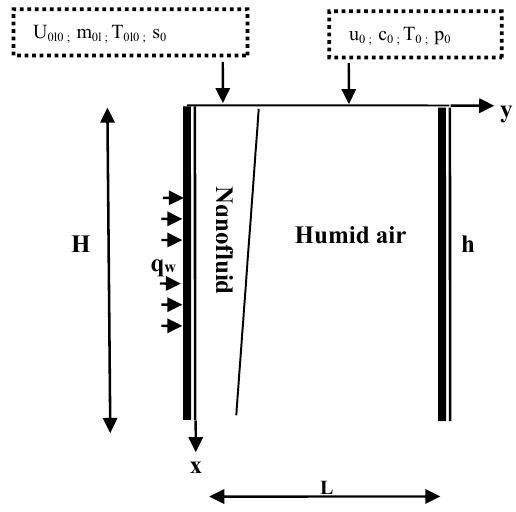
Figure 1. Physical Fig. 1: Physical System